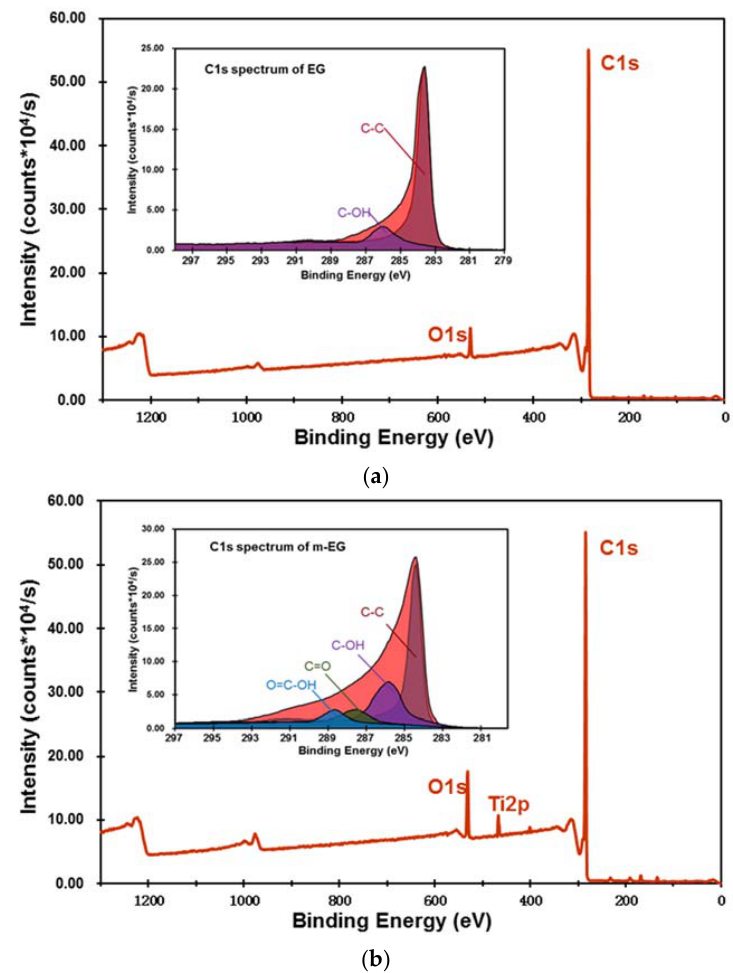
Figure 4. X ‐ ray photoelectron spectroscopy (XPS) spectra of the EG matrix ( a ) and the m ‐ EG matrix Figure 4. X-ray photoelectron spectroscopy (XPS) spectra of the EG matrix ( a ) and the m-EG matrix ( b ( b ).